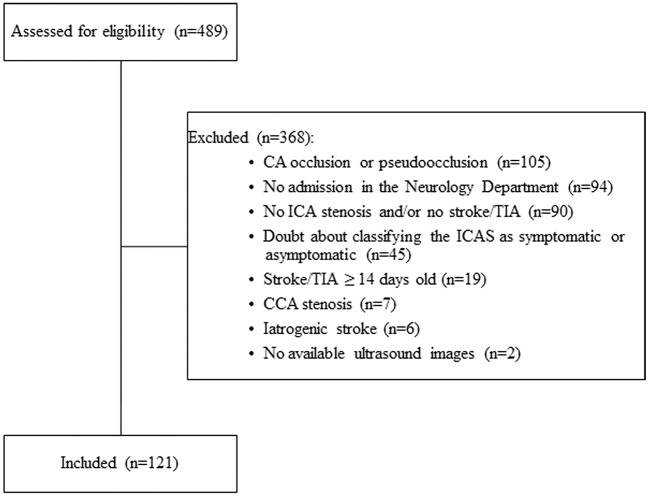
Flow chart showing the included and excluded patients from the current study. CA, carotid artery; CCA, common carotid artery; ICA, internal carotid artery; ICAS, internal carotid artery stenosis; TIA, transient ischemic attack, iatrogenic stroke (5 cases after carotid endarterectomy, 1 case after coronary angiography). Of the 489 patients screened, only 121 patients met our inclusion and exclusion criteria.